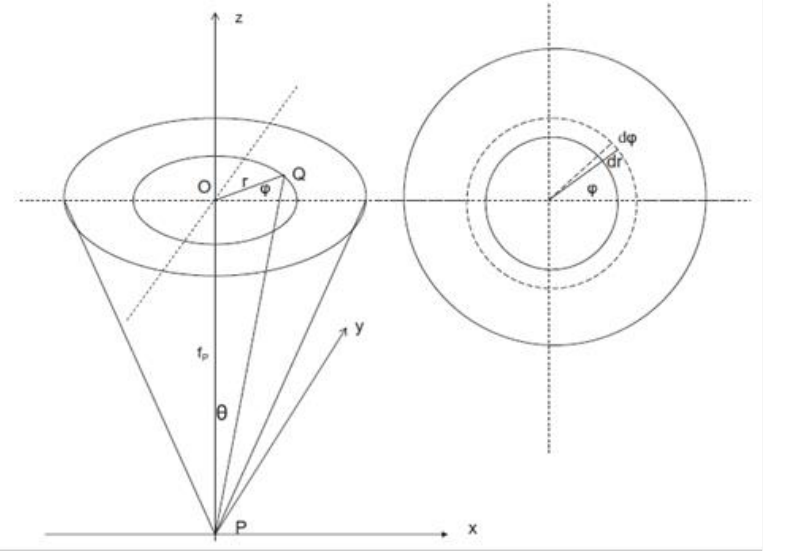
Figure 2. Efficiency calculation from the reflection point of a mirror when the radial distribution of brightness for an effective source is applied.